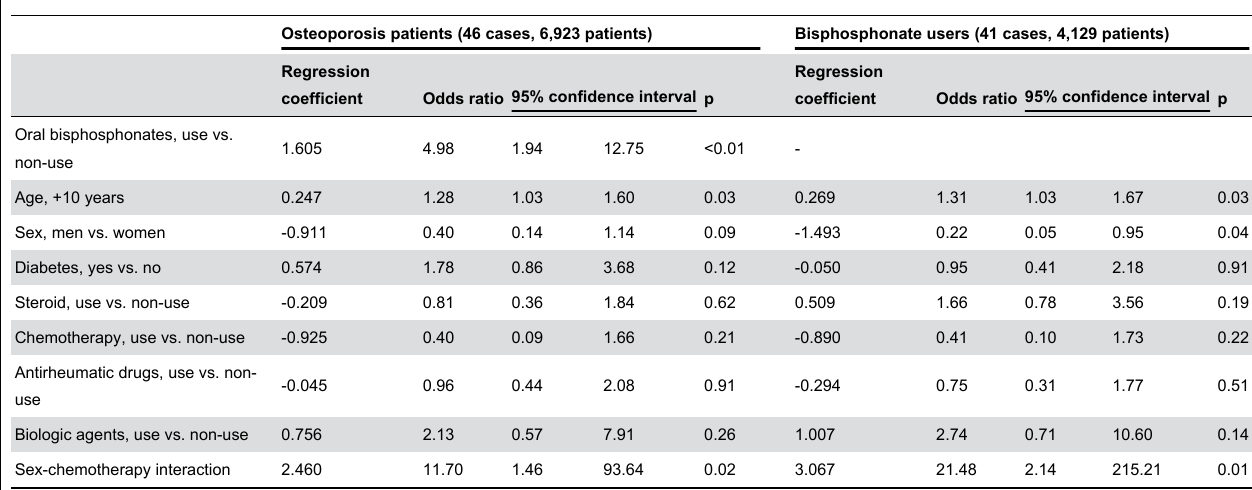
Table 2. Potential risk factors of osteomyelitis of the jaw in all osteoporosis patients and oral bisphosphonate